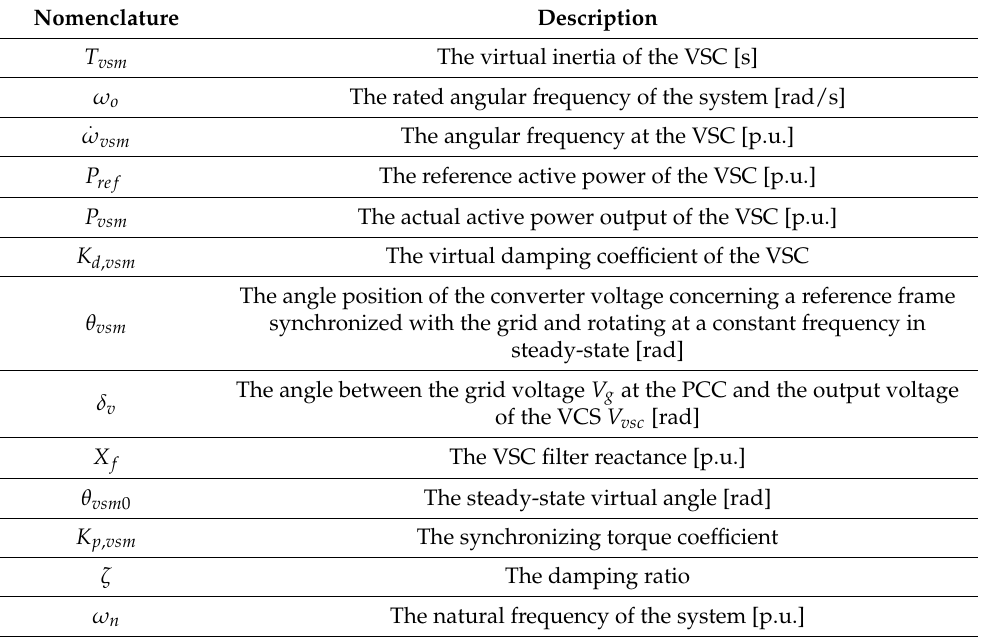
Table 2. Nomenclatures employed in Equations